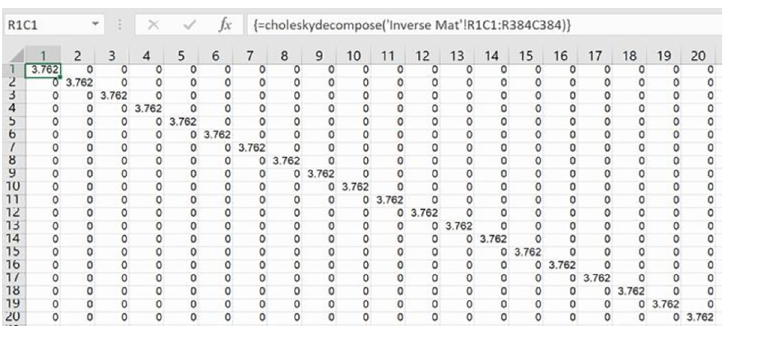
Fig 5. Partial Cholesky decomposition